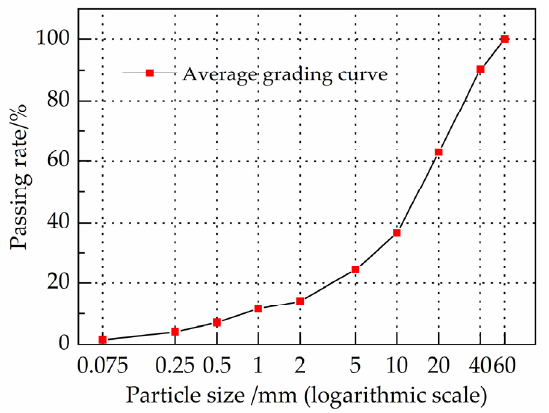
Figure 2. The average gradation curve of 10 crushed gangue samples.